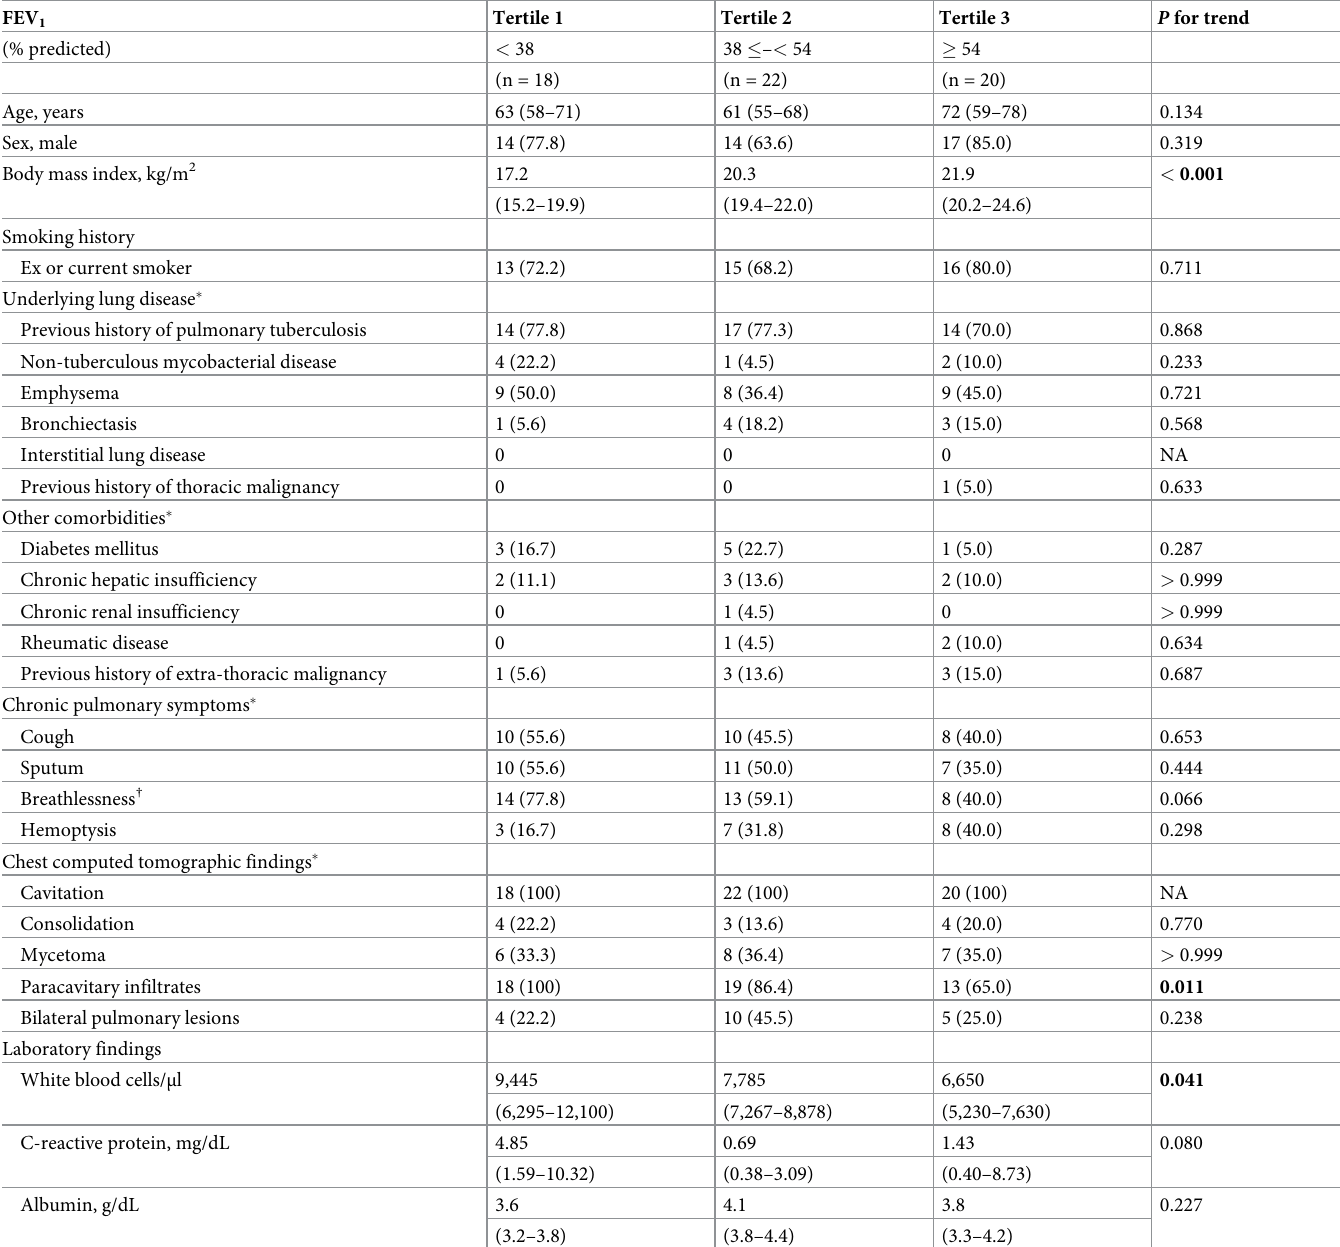
Table 4. OSP § patients’ characteristics by tertile of FEV 1 (%